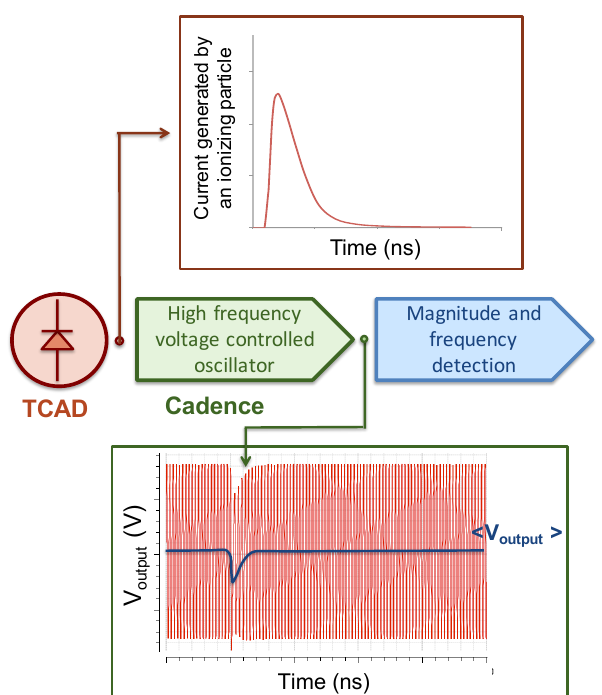
Fig. 1. Simulation chain including the current from TCAD modeling (top) and the variation of the output voltage versus time at the output of the VCO (bottom).